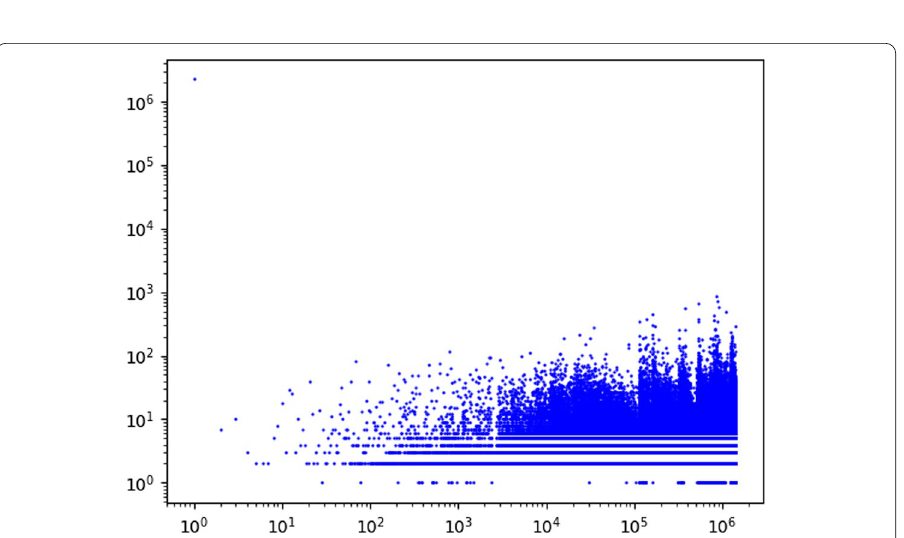
Fig. 2 x-axis: Size of components. y-axis: Number of components. The figure represents the distribution of the sizes of connected components of juridical organizations (companies). It contains one large component ( ∼ 2 millions nodes), and thousands of small components (between ten and a thousand